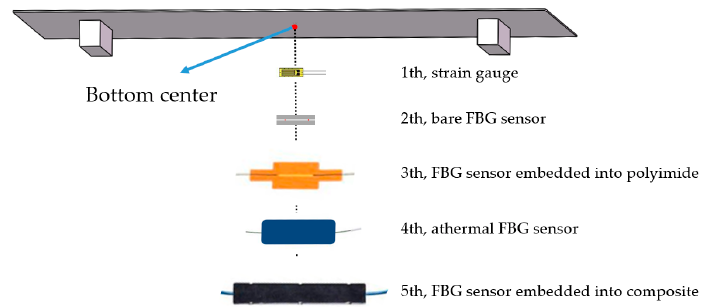
Figure 4. Schematic diagram illustrating the position and sequence when arranging sensors. The strain values measured by the five sensors under various loads are plotted in Figure 5, and compared with the simulated data from ANSYS. Table 1 shows all of the measured data from the sensors and the percentage differences compared with the simulation results. Moreover, the normal strain distribution of the plate corresponding to a load of 60 N is shown in Figure 6.